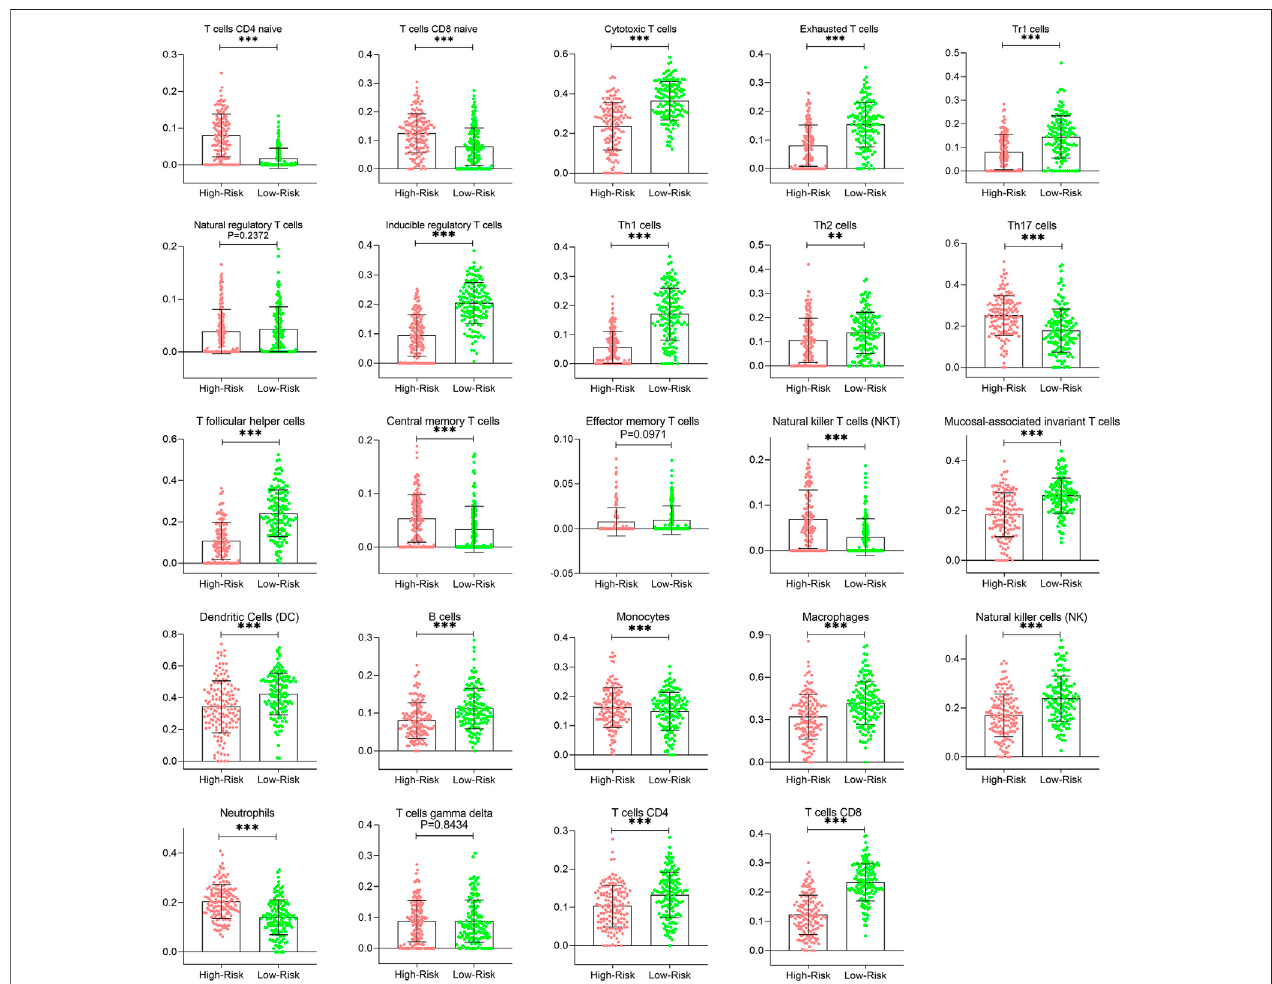
FIGURE 11 | Comparison of immune in fi ltration patterns of CESC patients between low- and high-risk groups. CESC, cervical squamous cell carcinoma.